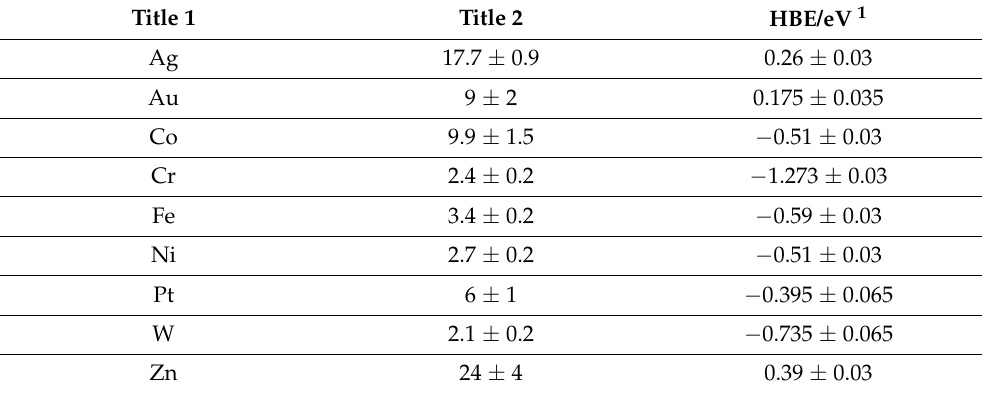
Table A1. Roughness factors and hydrogen binding energies (HBE) for the investigated